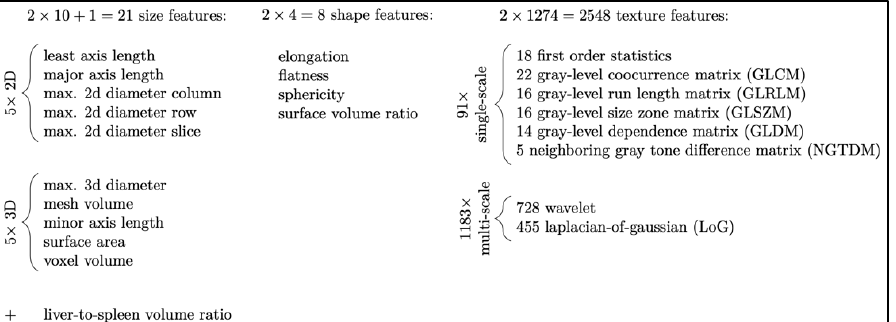
Figure 1. Radiomic features from liver and spleen were divided into high level classes (size, shape, and texture) to better explain their relative importance in each experiment. Note that in other literature, radiomics features of size and shape are typically combined into a single class. Distinct size and shape classes better correspond to human observations such as gross organ size and texture features such as surface nodularity, respectively.